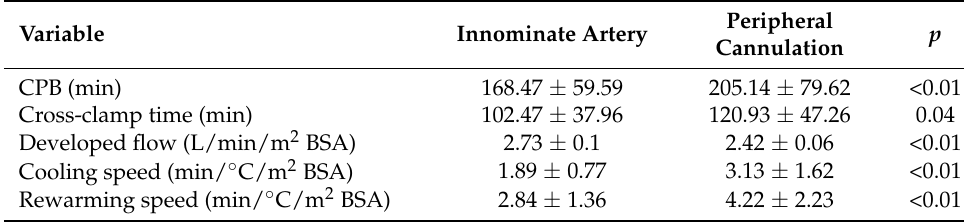
Table 2. Intraoperative perfusion measurements.